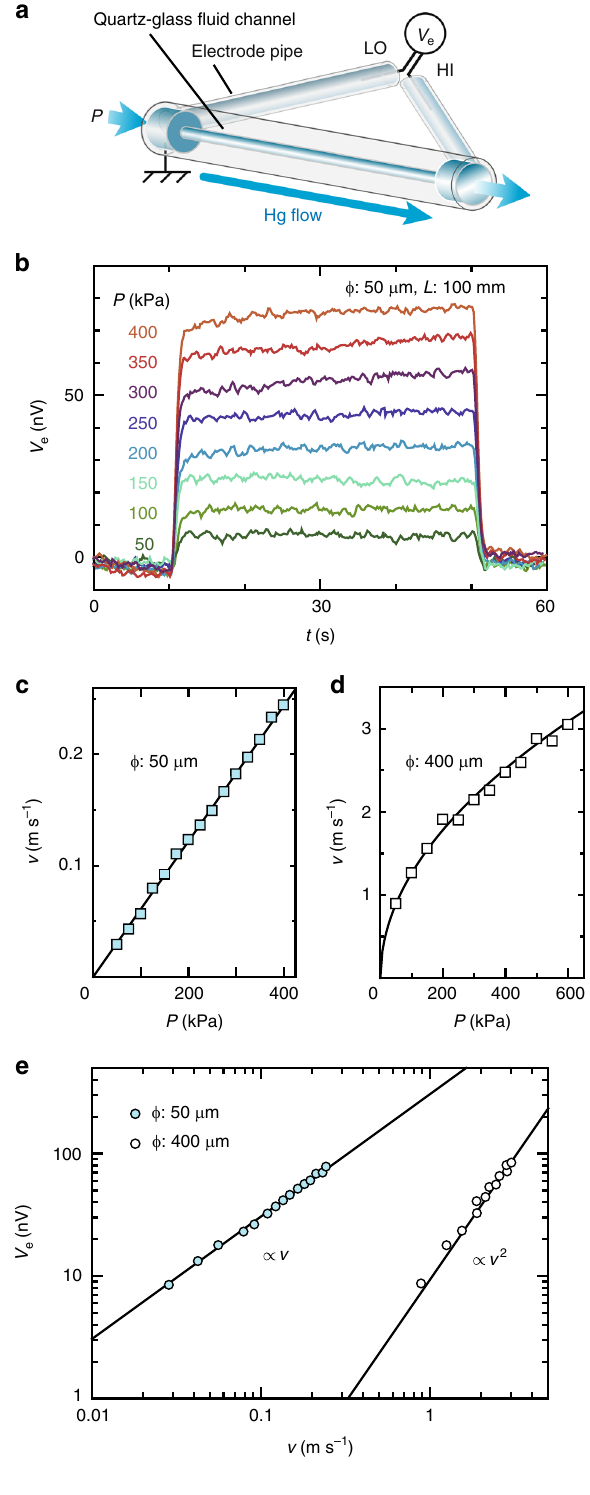
Fig. 2 Measurements of hydrodynamic voltage generation. a A schematic illustration of the fl uid channel used in the present study. A fl ow of liquid Hg in a quartz-glass fl uid channel is induced by applying pulsed pressure, P . V e denotes electric voltage difference between the ends of the channel. HI and LO denote the high and low terminals, respectively. b Time evolution of V e for various values of P in the fl uid channel whose inner diameter ϕ is 50 μ m and the length L is 100 mm. c P dependences of the mean fl ow velocity v for the channel used in ( b ). v is estimated by averaging the data obtained from repetitive measurements. The experimental results are well reproduced by a relation for laminar fl ow states: v ∝ P . d P dependence of v for the channel of ϕ = 400 μ m 12 , reproduced well by a relation for turbulent ffiffiffi p fl ow states: v / P . e v dependences of V e for the channels of ϕ = 50 μ